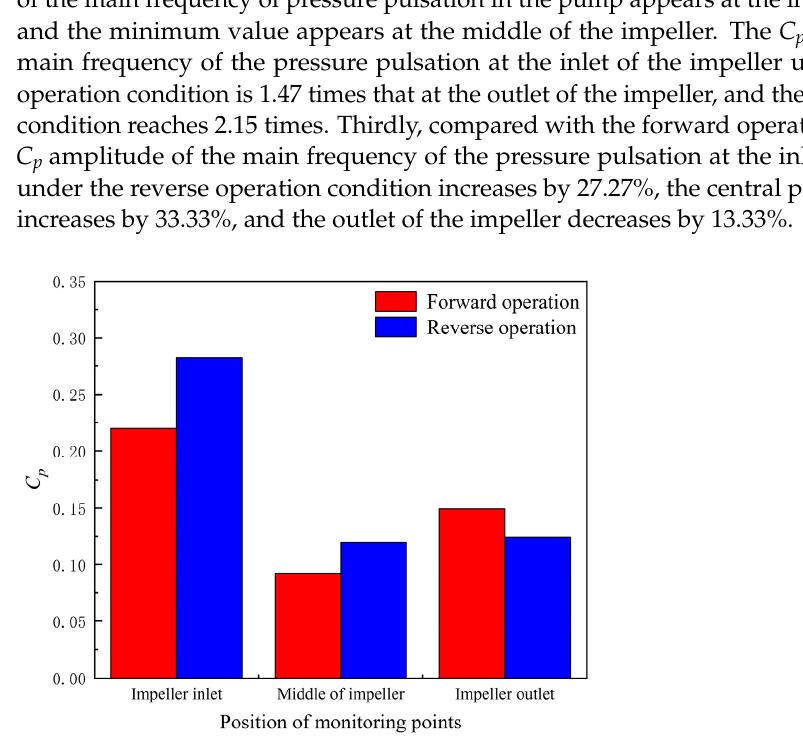
Figure 17. C p amplitude of main frequency of pressure pulsation of bidirectional axial flow pump at large flow rate of 1.20 Q bep